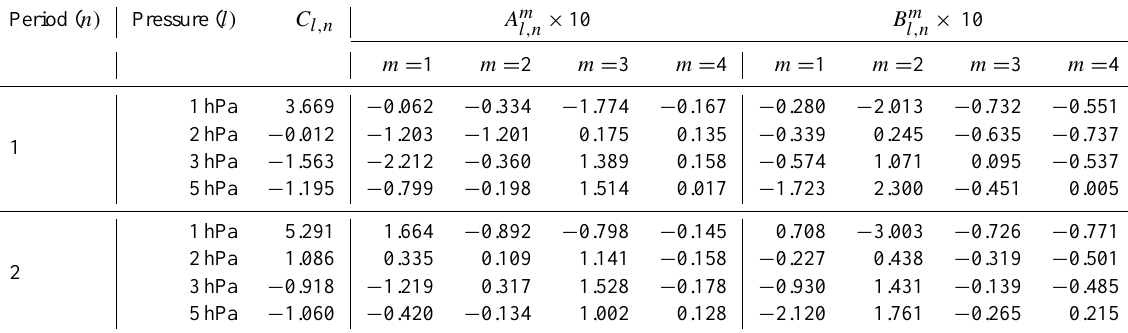
Table 1. Coefficients A m , B m and C l,n used in Eq. (1) for generating the 6-hourly global mean temperature offsets using the first four l,n l,n harmonics of the annual cycle for the two time periods. Period n = 1 extends up to 12:00UTC 21 March 1985; period n = 2 extends from 12:00UTC 21 March 1985 to 00:00UTC 1 August 1998. Units are K. In order to provide more precision, the coefficients A m multiplied by